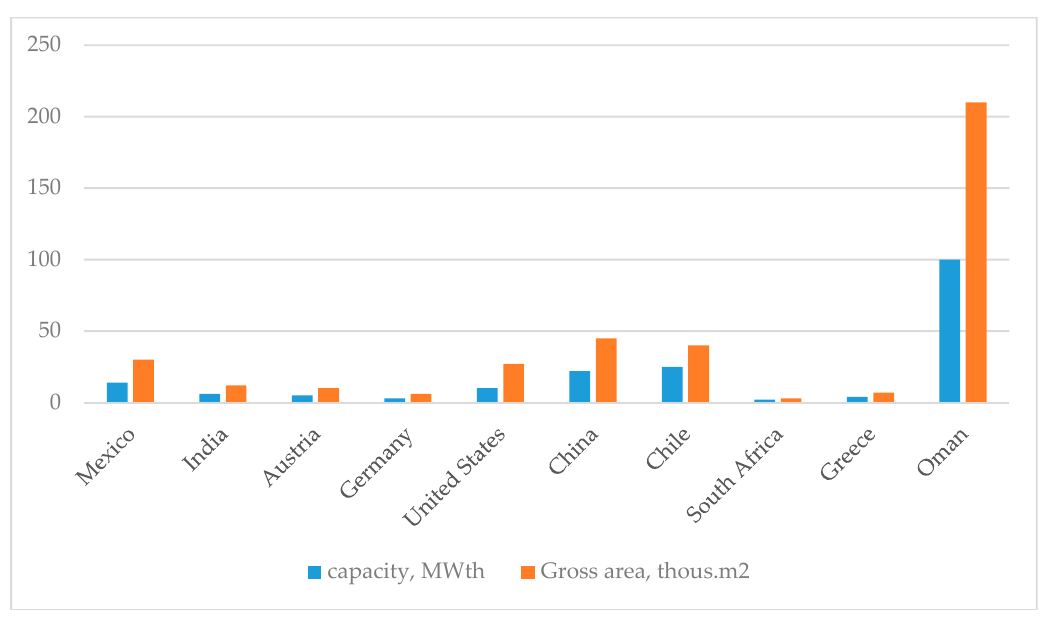
Figure 7. Cumulative area and cumulative power of installed solar collectors in the leading countries [23].